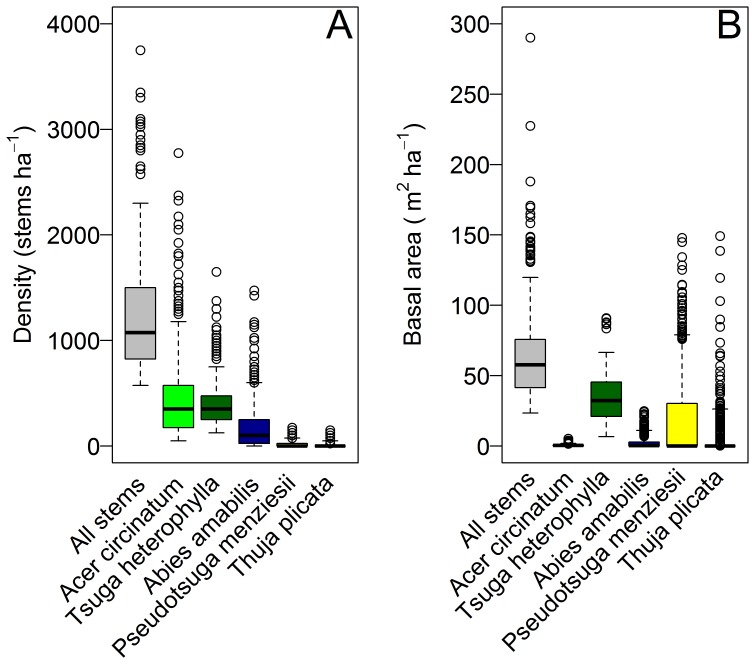
Heterogeneity in density and basal area of the five principal tree species of the Wind River Forest Dynamics Plot in 2012.Each boxplot represents values from the 640, 20×20 m quadrats of the plot. Boxplot boxes indicate the 25th percentile, median, and 75th percentile. Boxplot whiskers indicate the 5th percentile and the 95th percentile.